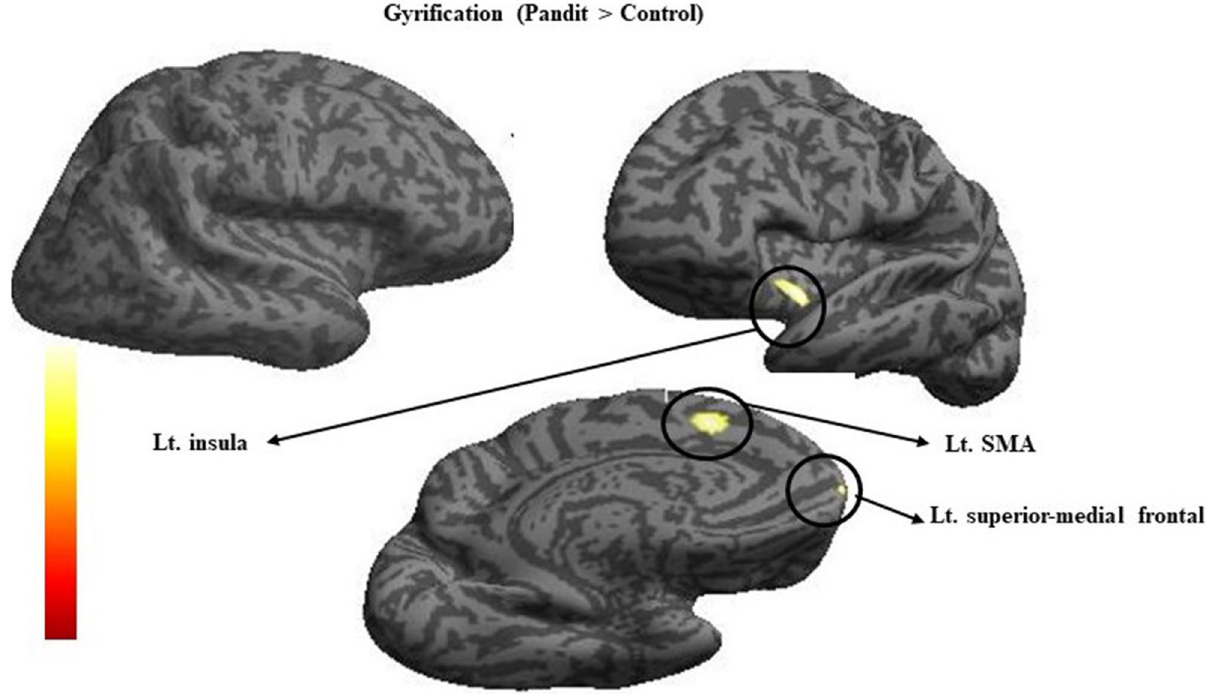
Figure 4. Results of gyrification group comparison using computation anatomy toolbox (CAT) rendered on to an inflated cortical surface. The image shows the result of the two-sample t -test comparing gyrification index value between Pandit/Priest, at a threshold of P < 0.05 (FWE) corrected.